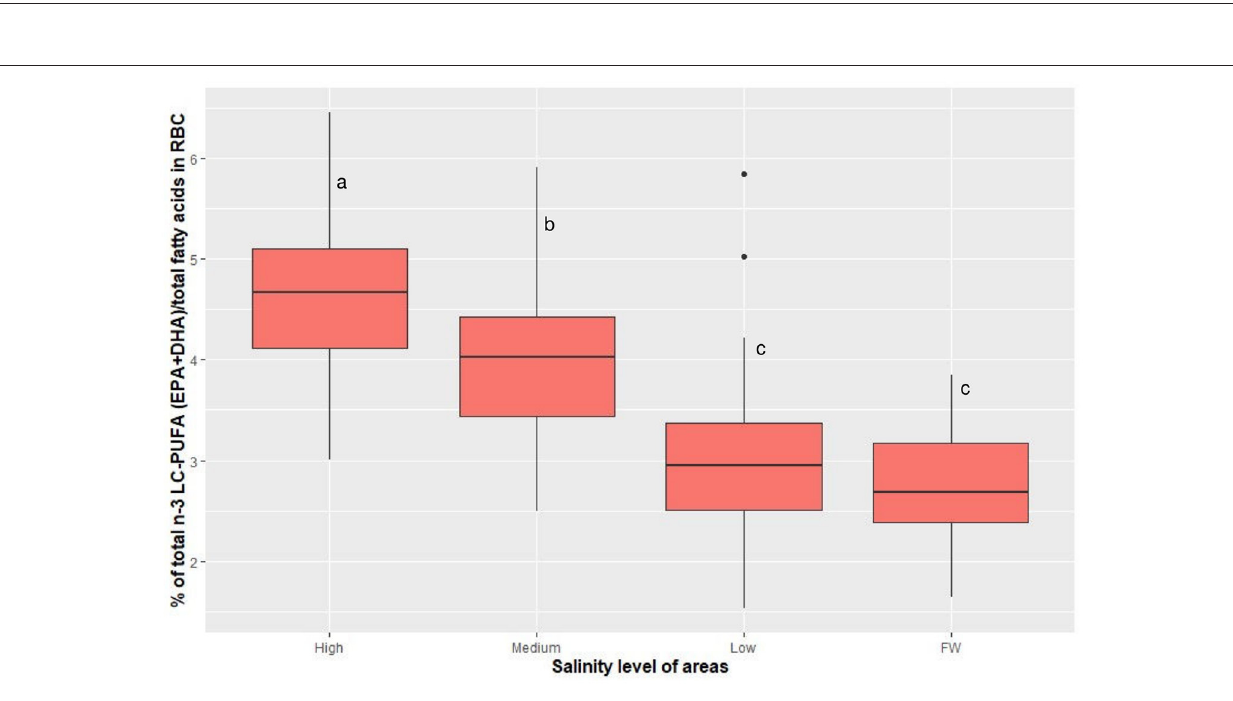
Frontiers in Sustainable Food Systems |